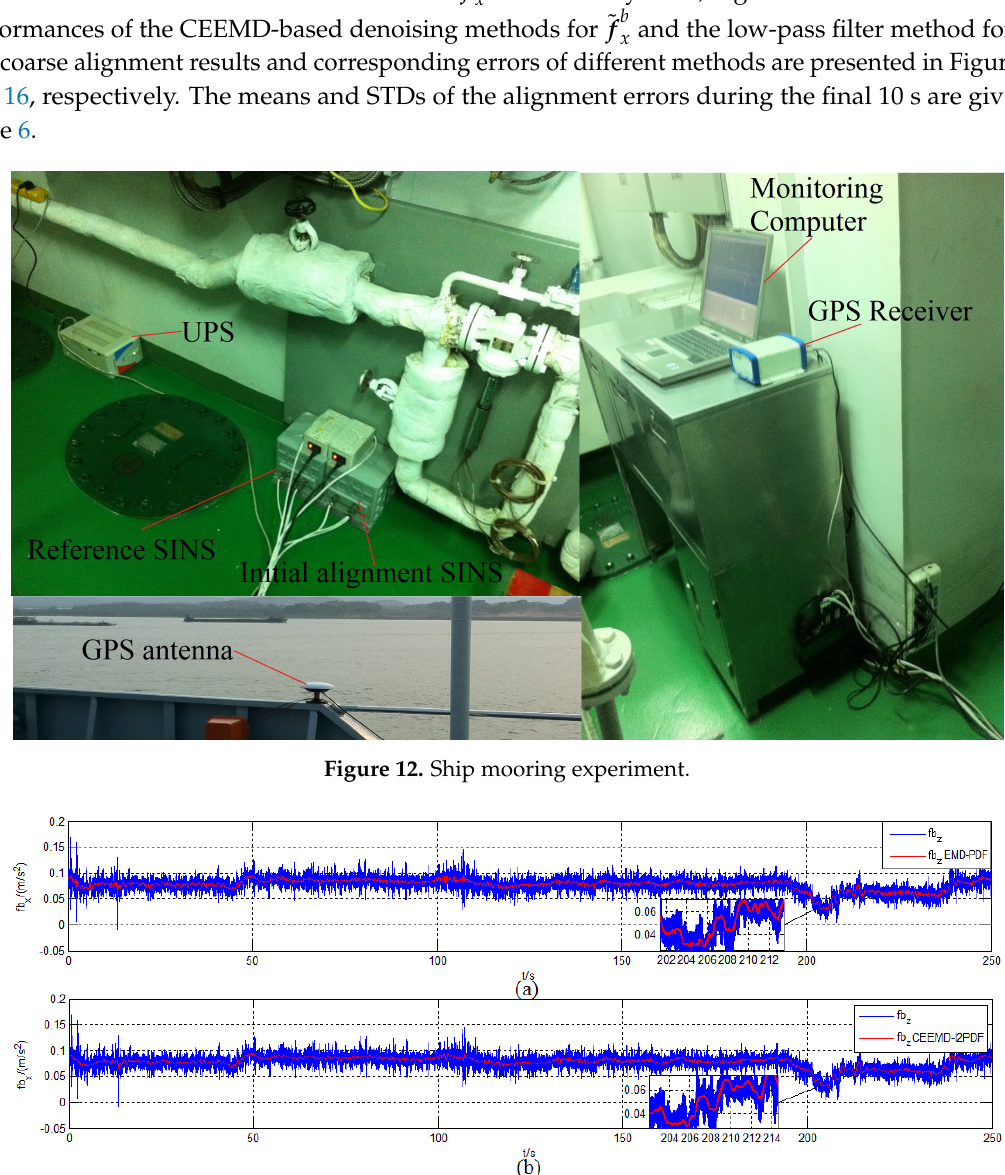
in the ship mooring experiment. ( a ) EMD-PDF method; x